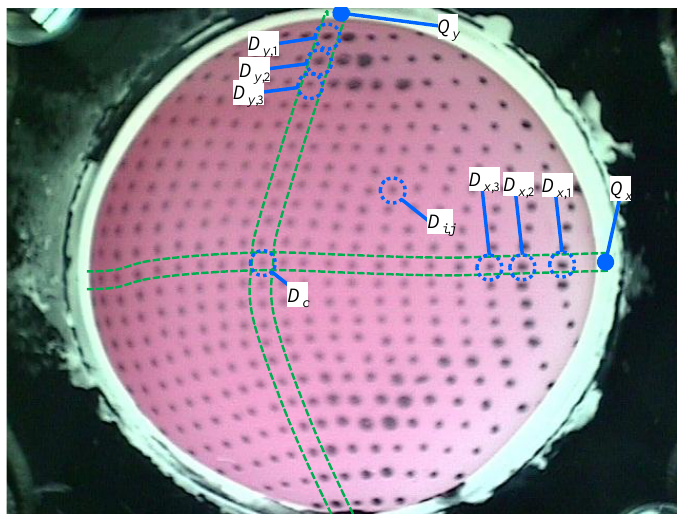
Figure 6. The process of assigning numbers to all dots in the image.